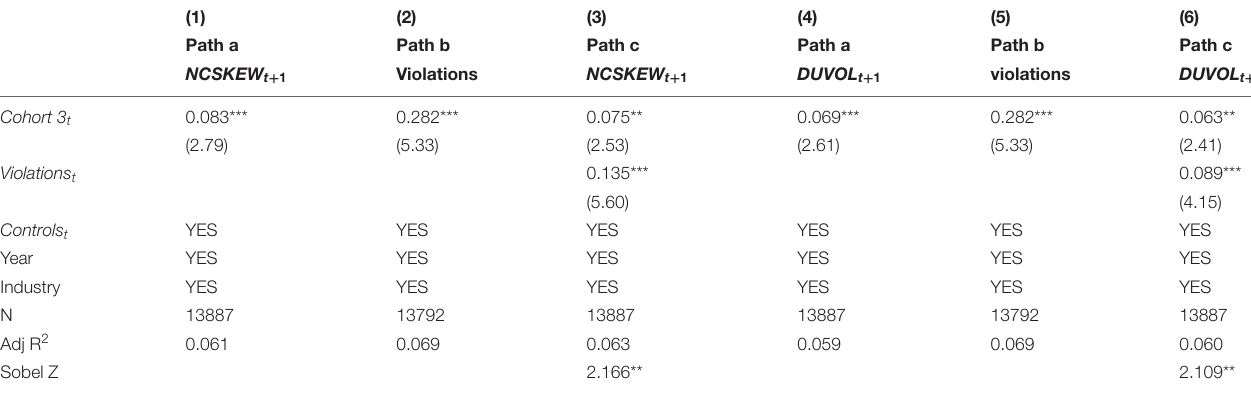
TABLE 9 | Channel test: Bad news